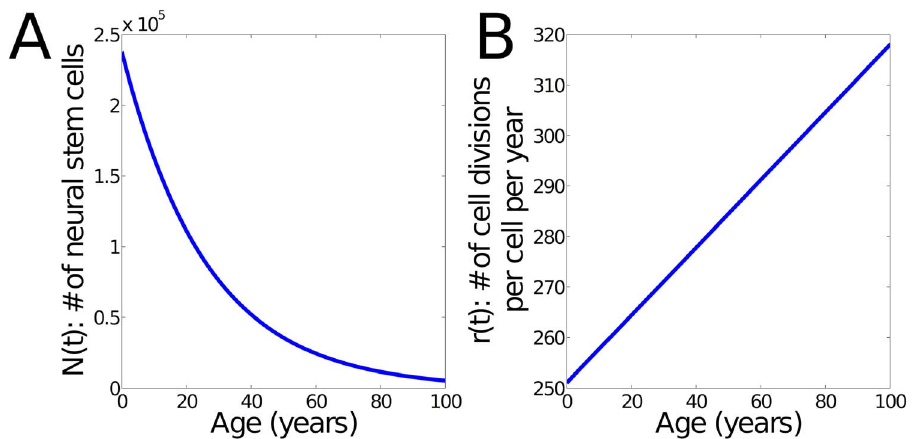
Figure 1. Modeled number and cell division rate of NSCs. (A) Number of NSCs during aging. The initial number of cells was estimated based on [18]. The number of NSCs is given by N ( t ) ~ N 0 e { d : t using d ~ 0 : 038 . (B) Modeled cell division rate over time. As shown in [13], NSCs increase their rate during aging. We have approximated this behavior using a linear interpolation from 251 to 318 divisions per cell and year.